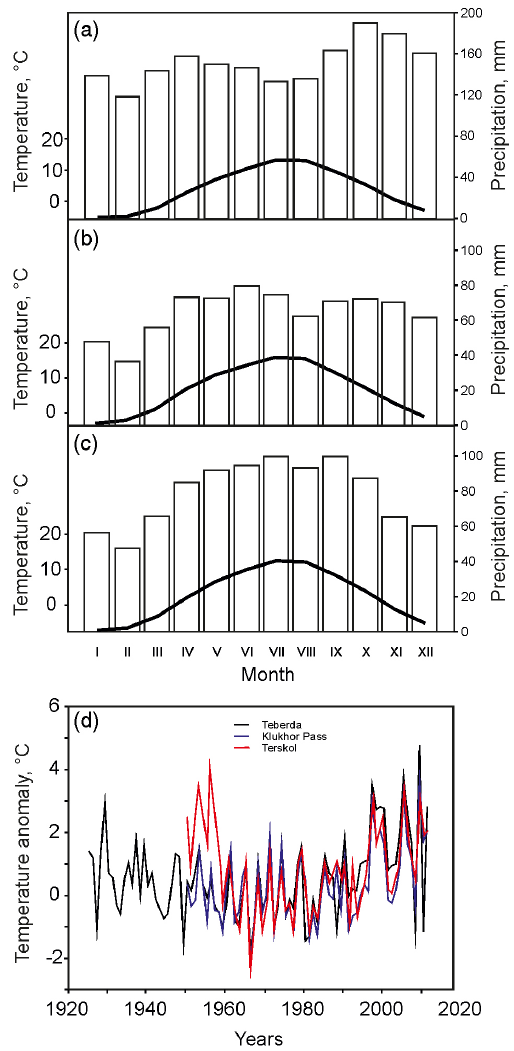
Figure 2. Mean monthly air temperature and precipitation at the Klukhor Pass (a) , Teberda (b) , and Terskol (c) meteorological sta- tions and (d) anomalies of mean summer temperature with devia- tions from the mean 1961–1990